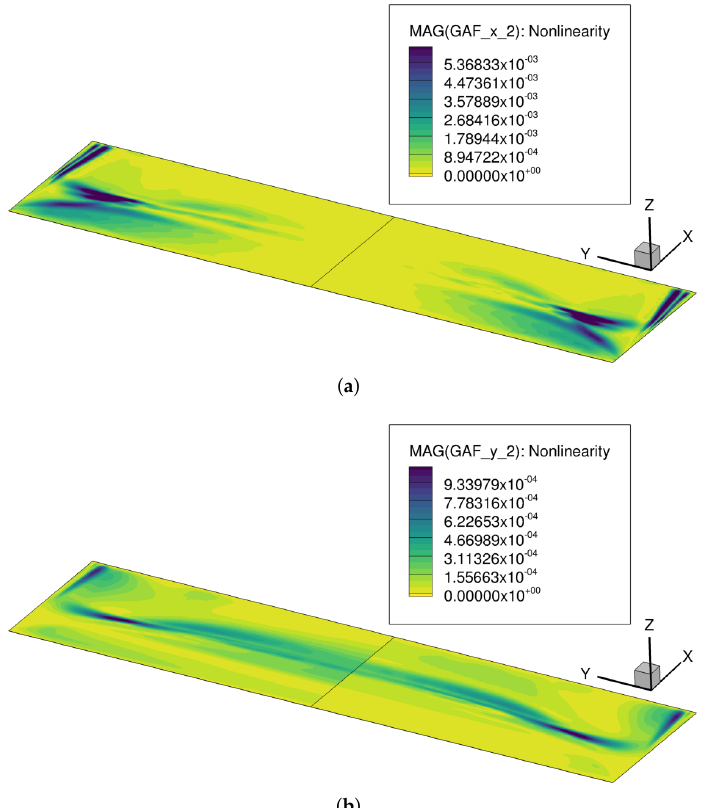
Figure 18. Spatial locations of nonlinear components of Q hh ( 2,1 ) (viscous flow, Mach 0.8. Positive semi-span: linear modal, negative semi-span: extended modal). ( a ) Longitudinal GAF component; ( b ) lateral GAF